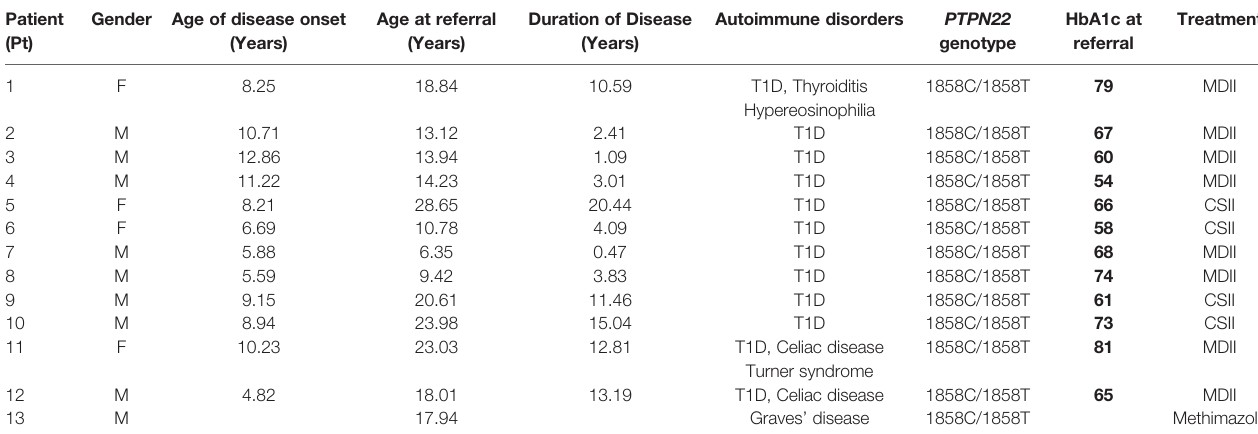
TABLE 1 | Demographic, genetic and clinical characteristics of patients of the present study. Patient